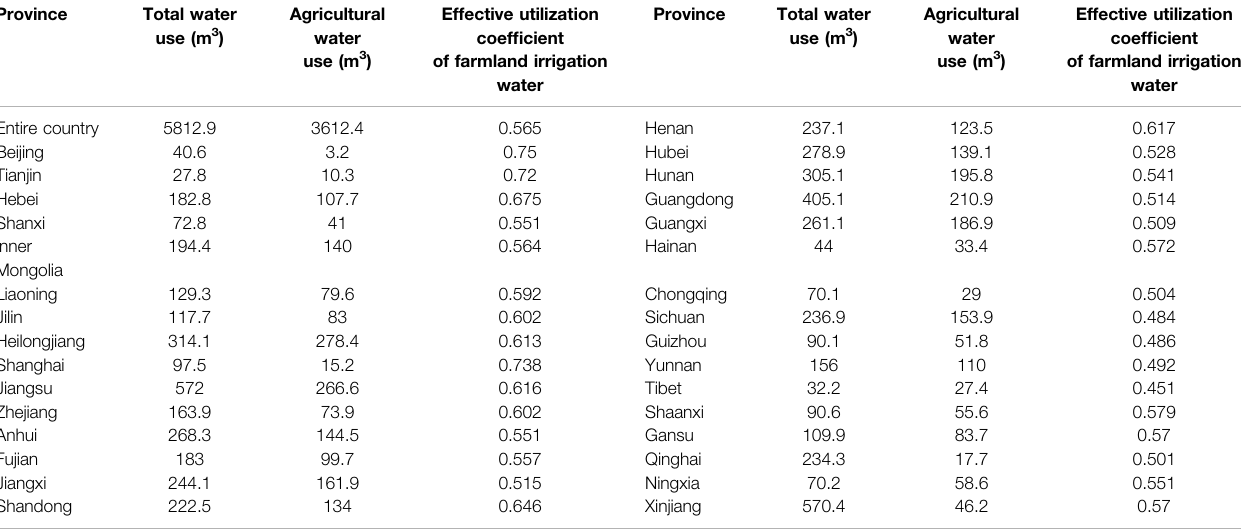
TABLE 1 | Agricultural water consumption and the effective utilization coef fi cient of farmland irrigation water in 2020.